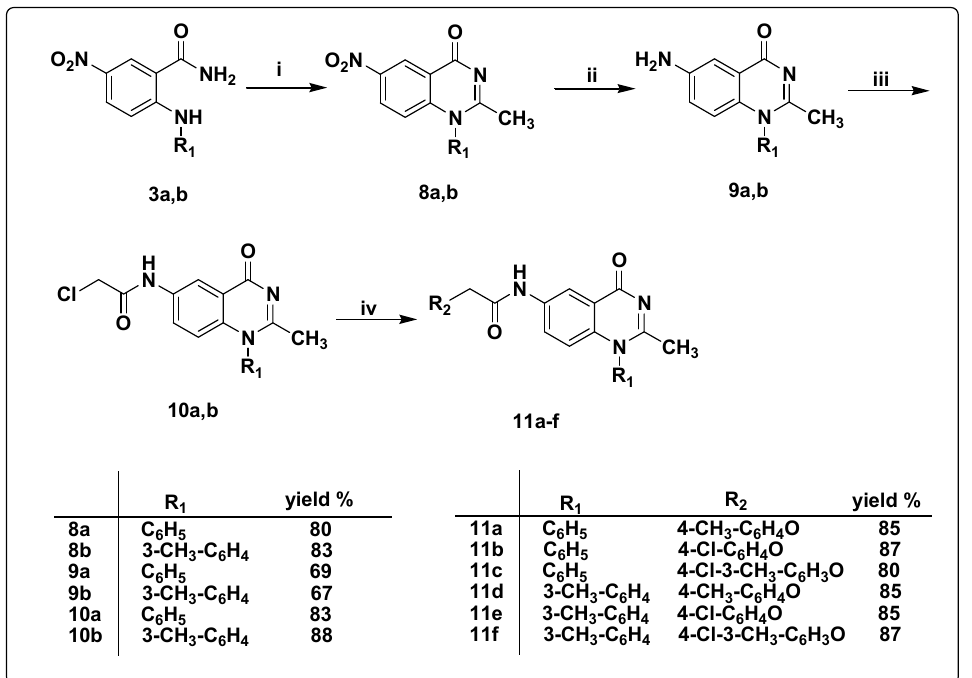
Scheme 3. Synthesis of the target quinazoline derivatives 11a–f (i) acetic anhydride, sulfuric acid, fusion, 100 °C, 8h; (ii) SnCl 2 , HCl, r.t, 2h; (iii) chloroacetyl chloride, CH 2 Cl 2 , K 2 CO 3 , r.t, 3h; (iv) sub- stituted phenols, K 2 CO 3 , CH 3 CN, 90 °C, 8h.